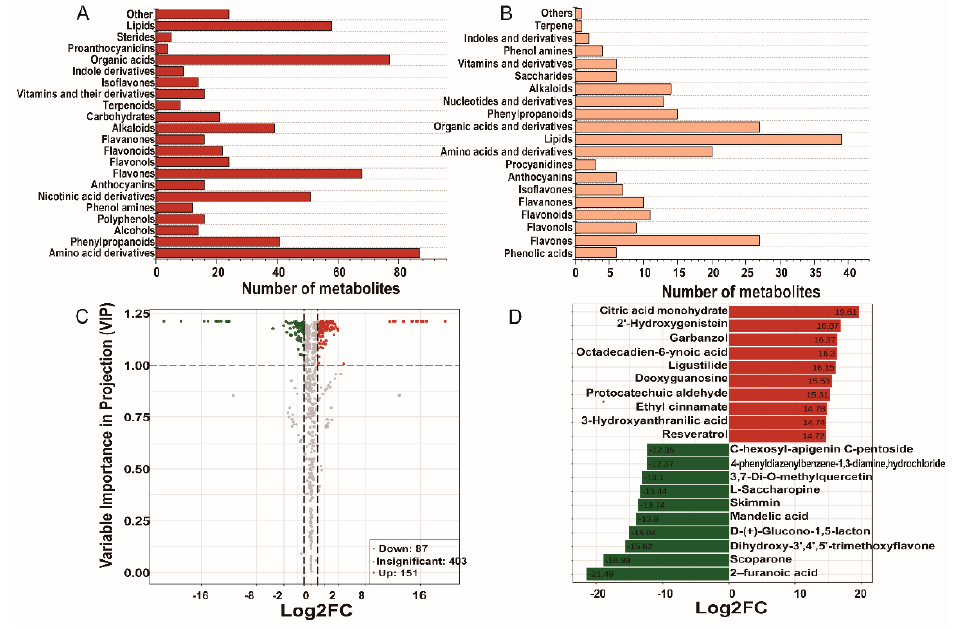
Figure 4. Different metabolites in WS and CS. ( A ) Number of different types of total metabolites. ( B ) Number of different types of significantly different metabolites. ( C ) Volcano plot. Significantly up- and downregulated metabolites are indicated in red and green, respectively. Those without significant difference between the two groups are indicated in grey. A greater absolute value on the horizontal axis indicates a greater change between WS and CS. A greater value on the vertical axis indicates greater significance of the relative differential content. ( D ) Histogram of the fold changes of the metabolites of the first 20 compounds that differed between WS and CS. The abscissa represents the log2 of multiples, and ordinates represent the different metabolite